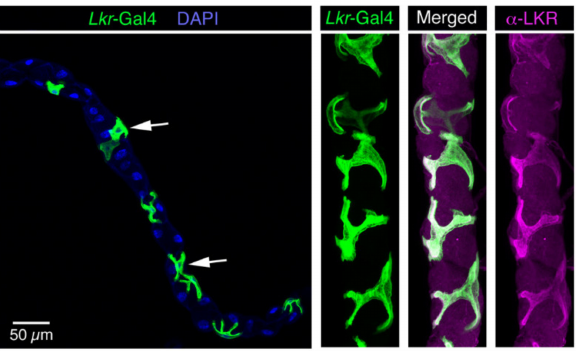
Figure 3. Expression of leucokinin receptor Gal4 ( Lkr -Gal4) in stellate cells of the Malpighian tubules of adult Drosophila . Arrows indicate stellate cells. Nuclei are stained with DAPI (blue). The stellate cells also label with antiserum to the Drosophila LKR (shown in magenta). Figure reproduced from [38] with permission from the publisher.